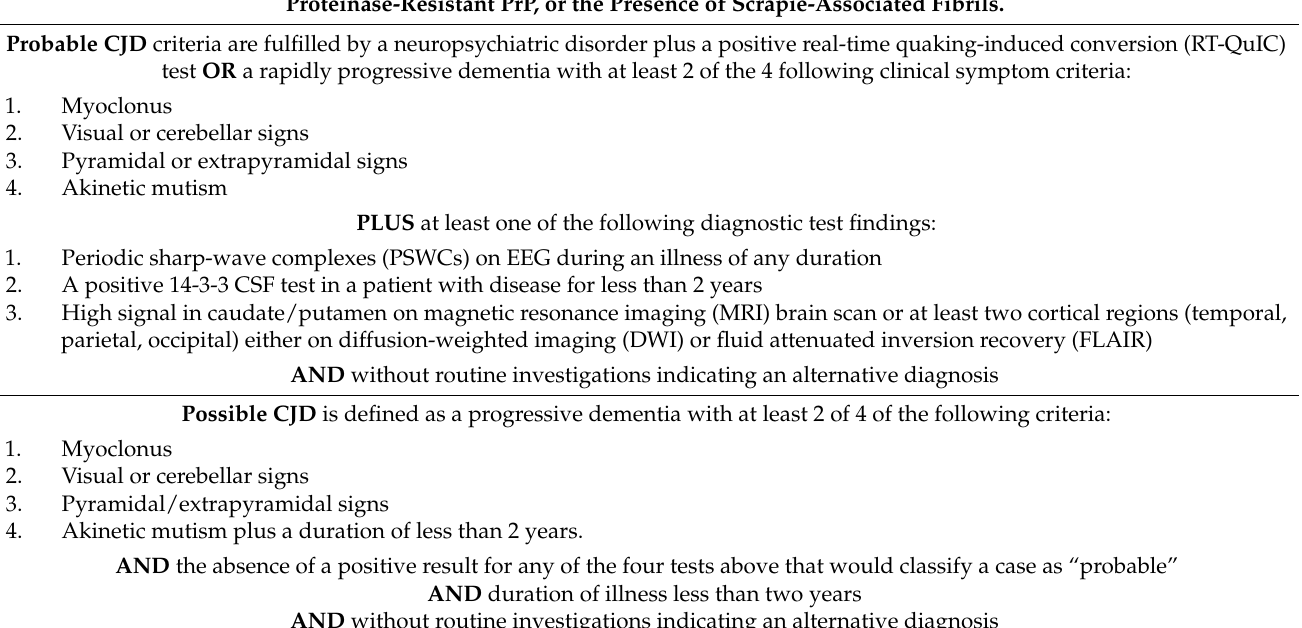
Table 1. Diagnostic criteria for Creutzfeldt–Jakob disease